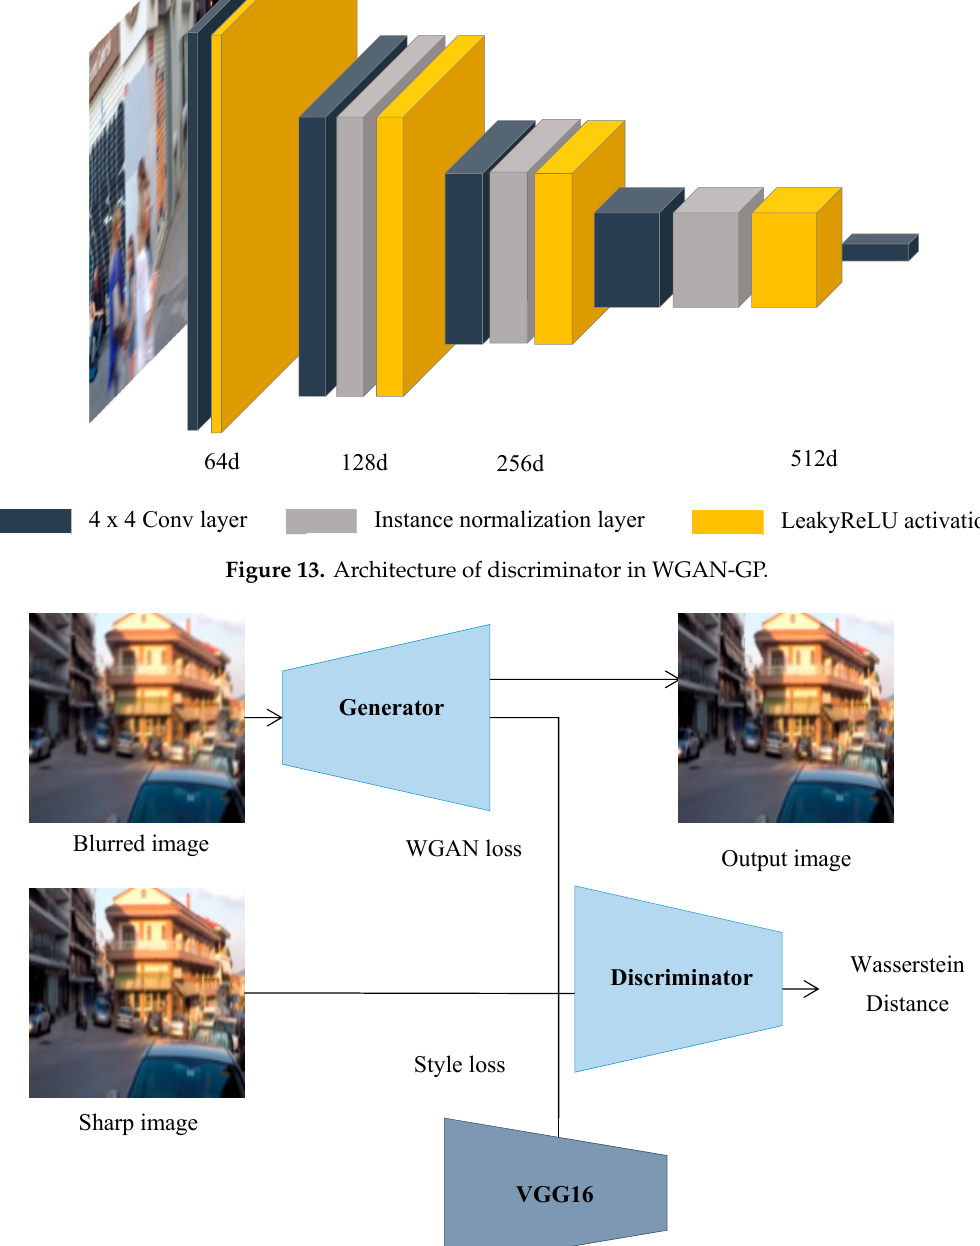
Figure 14. Configuration diagram for the entire network.